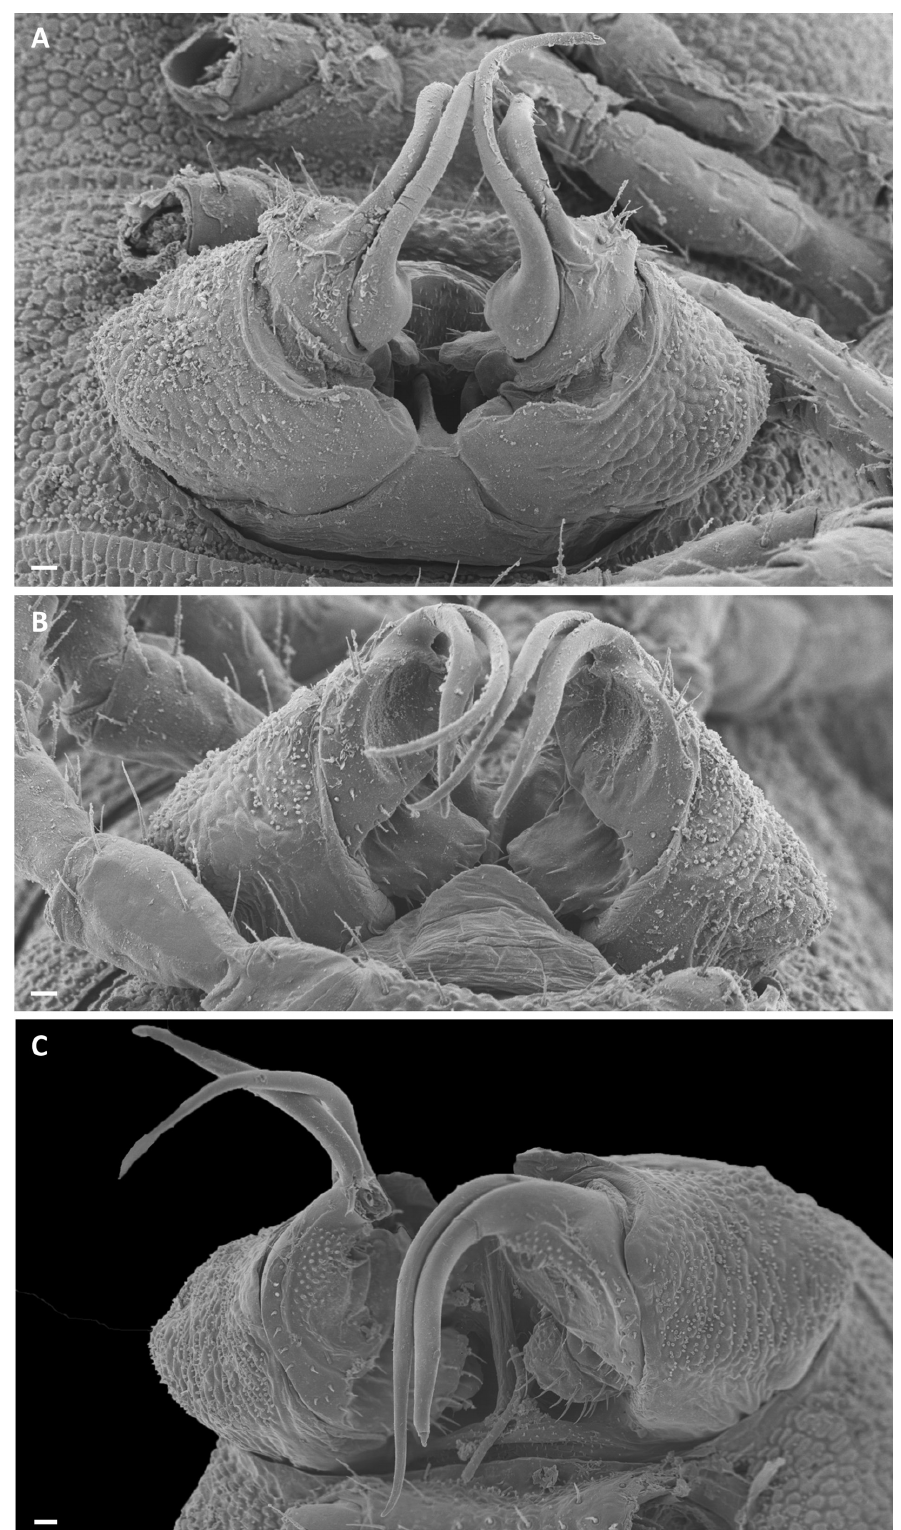
Fig. 5. Cryptocorypha geminiramus sp. nov., gonopods in situ . A–B . Paratype (NHMD 621824), ♂, from Kidatu. A . Ventro-anterior view. B . Subposterior view. C . Paratype (NHMD 621829), ♂, from Mitu Mitatu, latero-posterior view. Scale bars = 0.01